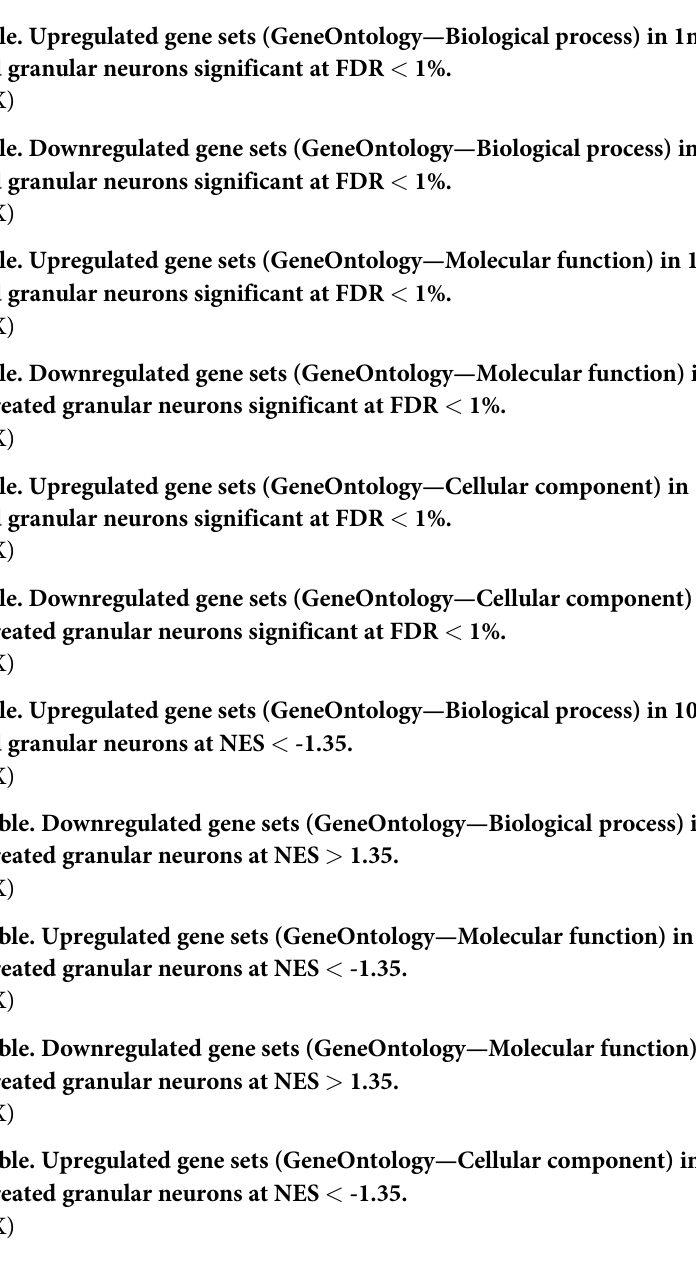
S12 Fig. Summary of downregulated gene sets (GeneOntology—Cellular component) in 100nM ouabain-treated granular